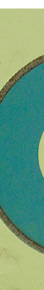
Figure 1. ( a ) Schematic of the thin high electron mobility transistor (T - HEMT) structure cross section with ohmic and Schottky contacts and ( b ) the calculated band diagram and electron density distribution in the upper layers of the heterostructure.